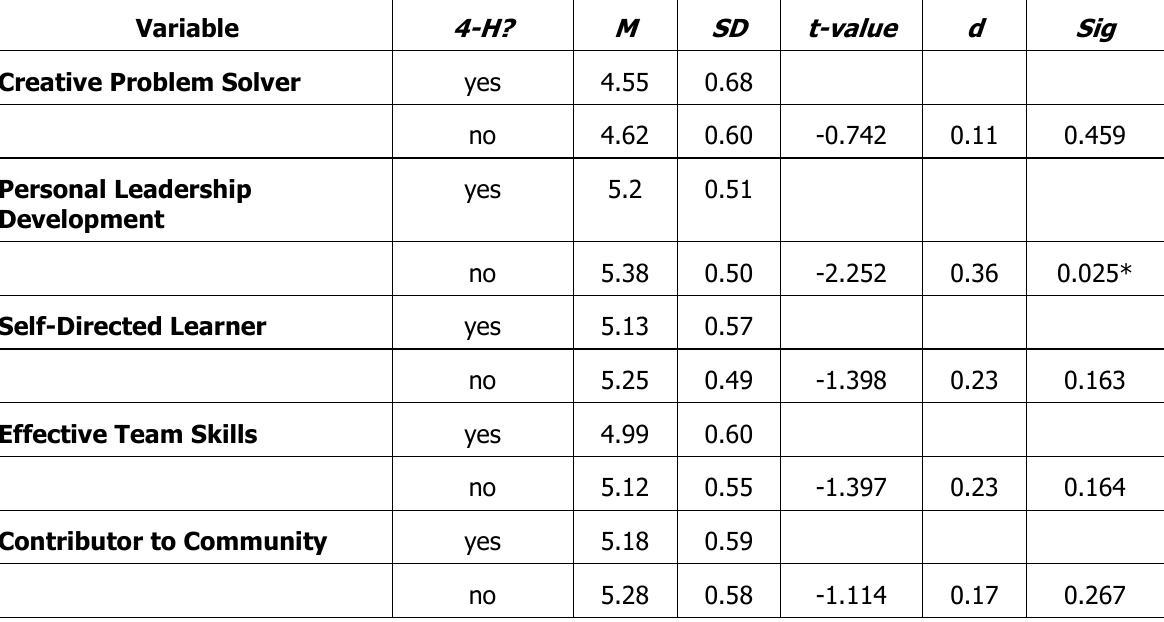
The Impact of 4-H Membership in the Development of Leadership Life Skills by Participants in a